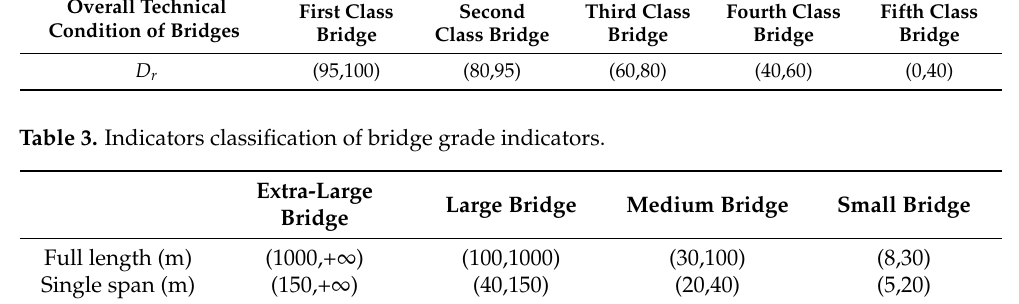
Table 2. Indicators classification of bridge technical conditions. Weighted Mark for Overall Technical